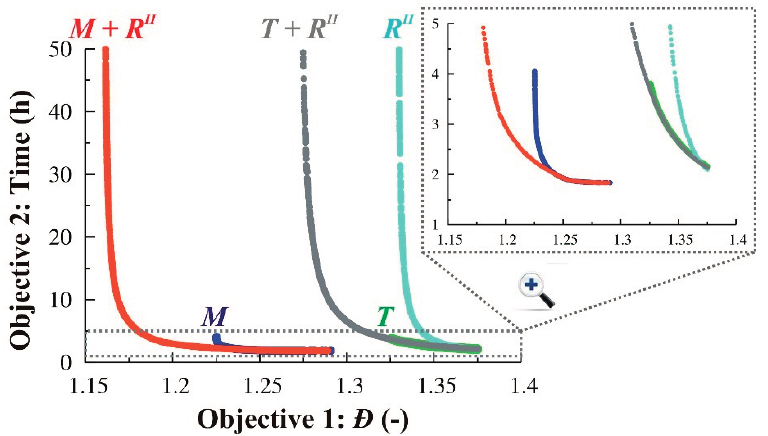
Figure 6. Comparison between multi-objective optimization (MOO) results of the different individual optimization pathways: fed-batch addition of reducing agent ( R II ) (teal; Figure 5a), temperature program ( T ) (green; Figure 2a), fed-batch addition of monomer ( M ) (blue; Figure 3a), the synergetic combination of temperature program and fed-batch addition of reducing agent (grey), and the synergetic combination of fed-batch addition of monomer and reducing agent